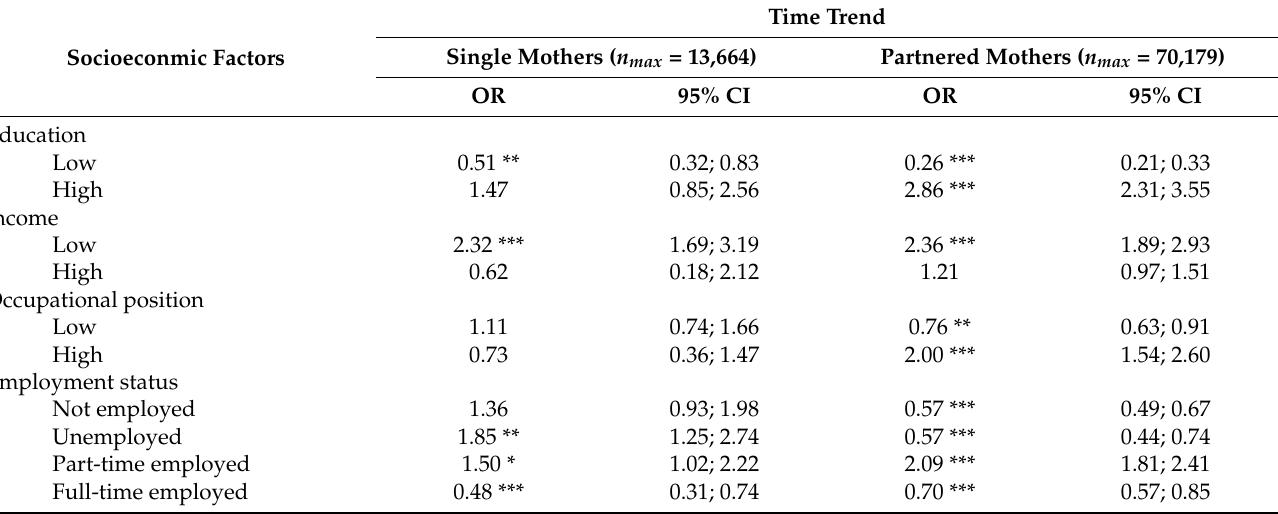
Table 5. Development of socioeconomic factors in single and partnered mothers aged 30–49 years in Germany, 1994–2018.